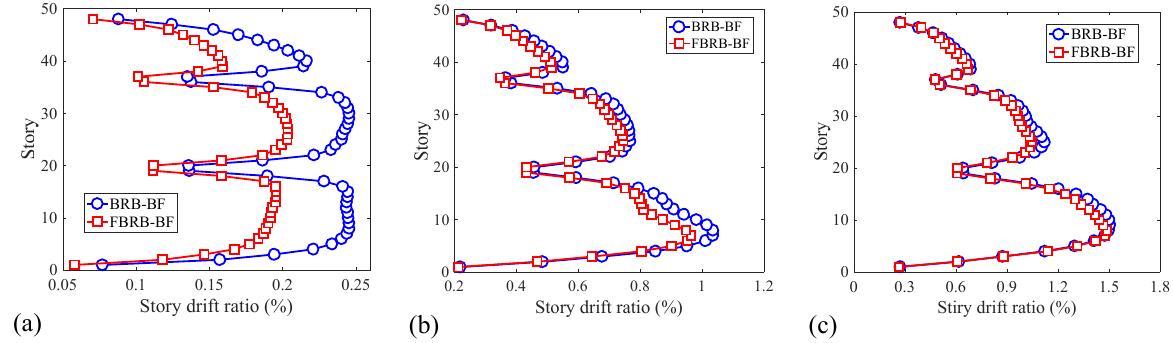
Figure 15. Average responses of the inter‑story drift ratio: ( a ) under FOE; ( b ) under MCE; and ( c ) under SRE.